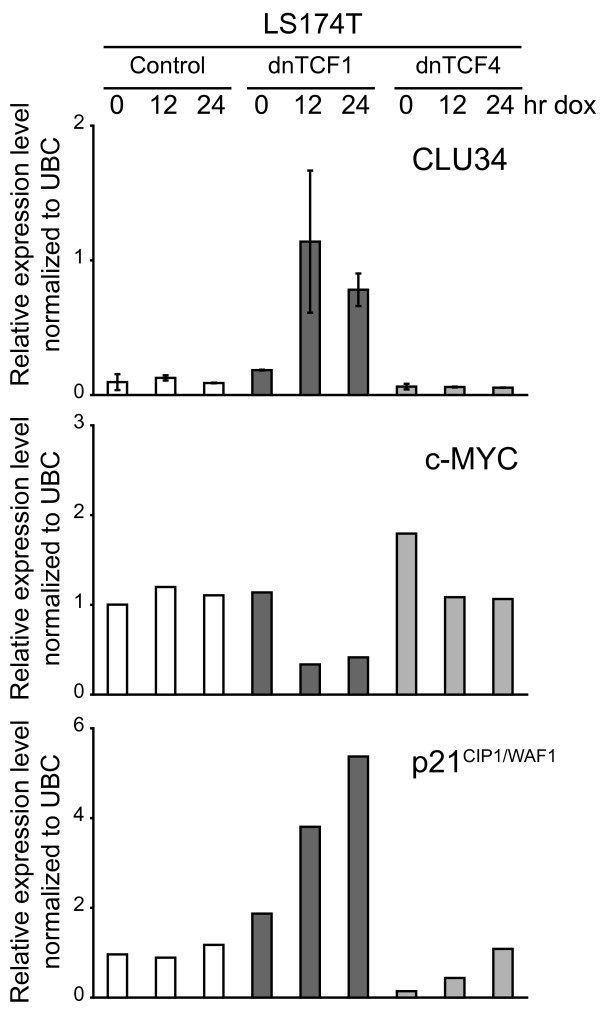
Alterations of CLU, p21, and c-MYC mRNA levels after induction of dnTCFs in LS174T cells. The expression levels of various transcripts were monitored by real time RT-PCR after induction of dnTCFs in LS174T derived cell lines. Expression levels were normalized to the Ubiquitin C (UBC) transcript. The CLU34 mRNA variant is specifically up-regulated in response to dnTCF1 over-expression in LS174T cells. Data are presented as the mean ± standard deviation from 2 separate experiments with each experiment consisting of the mean value of 3 independent determinations. c-MYC mRNA levels decrease, whereas p21CIP1/WAF1 mRNA levels increase after induction of both dnTCFs.